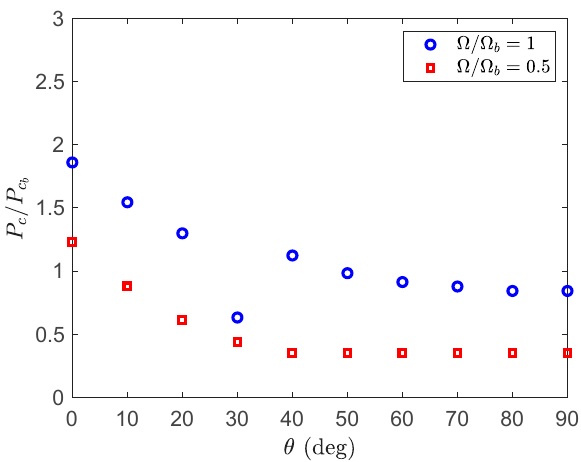
Figure 10. The effect ply angle on the critical instability force. Figure 10. The e ff ect ply angle on the critical instability